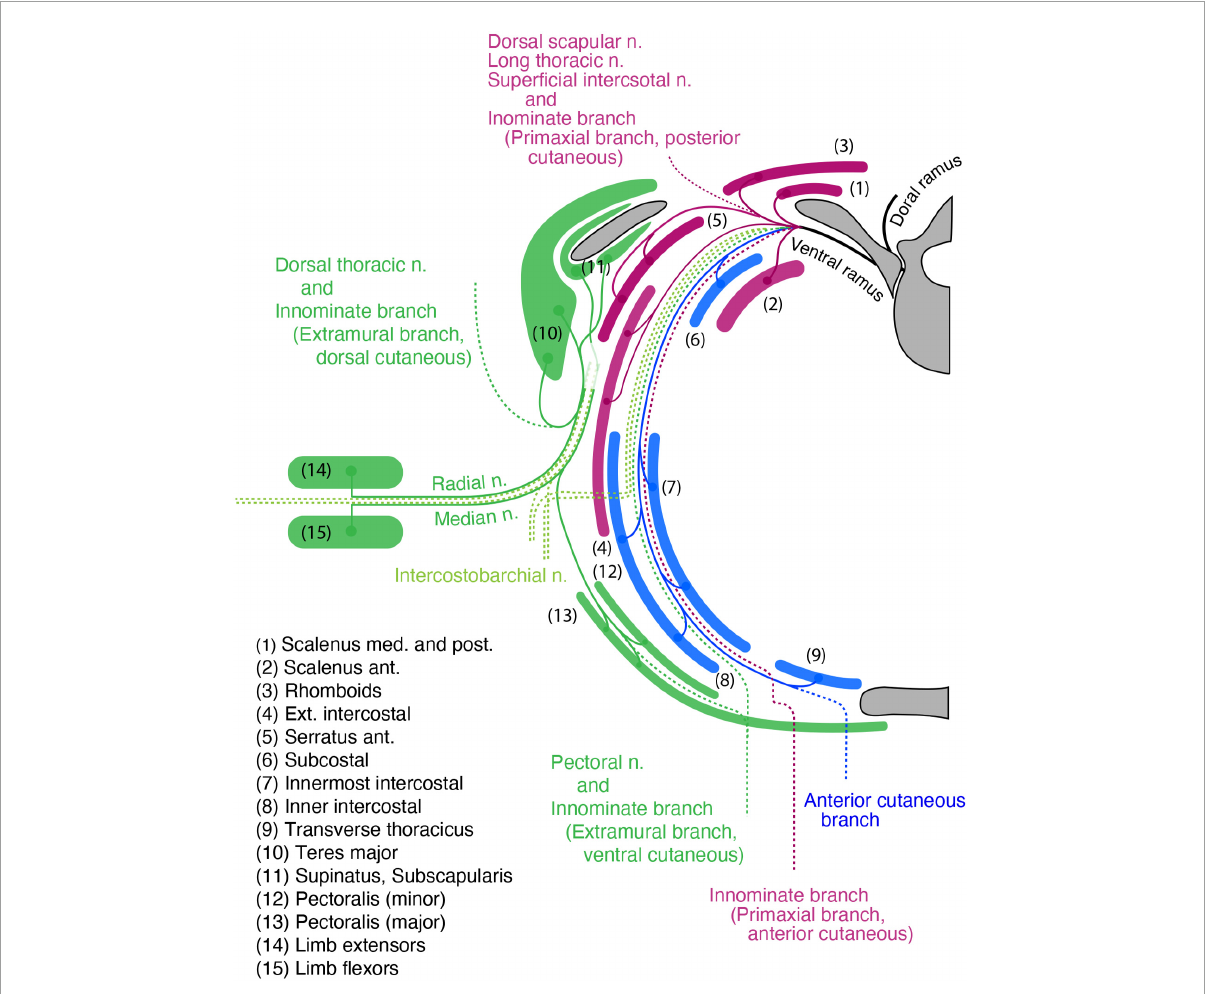
FIGURE13 The hypothetical branching pattern of the brachial spinal nerves projected onto a transverse plane around the level of the fifth thoracic vertebra. The primaxial, intramural, and extramural branches, as well as their target muscles, are color-coded: purple for primaxial, blue for intramural, and dark green for extramural components. The dotted lines are the cutaneous branches. The names of the muscles are numbered. Primaxial branches: direct branches to the scalenus muscles, the long thoracic nerve to the serratus anterior muscle, and the dorsal scapular nerve to the rhomboids. The posterior primaxial cutaneous branch is innominate. The extramural branches are the thoracodorsal nerve to the latissimus dorsi and teres major, subscapular nerve to the subscapularis, and pectoral nerves to the pectoralis. The LCB carries extramural motor innervations into the radial and median nerves in the upper limb. The cutaneous extensions of the extramural branches are